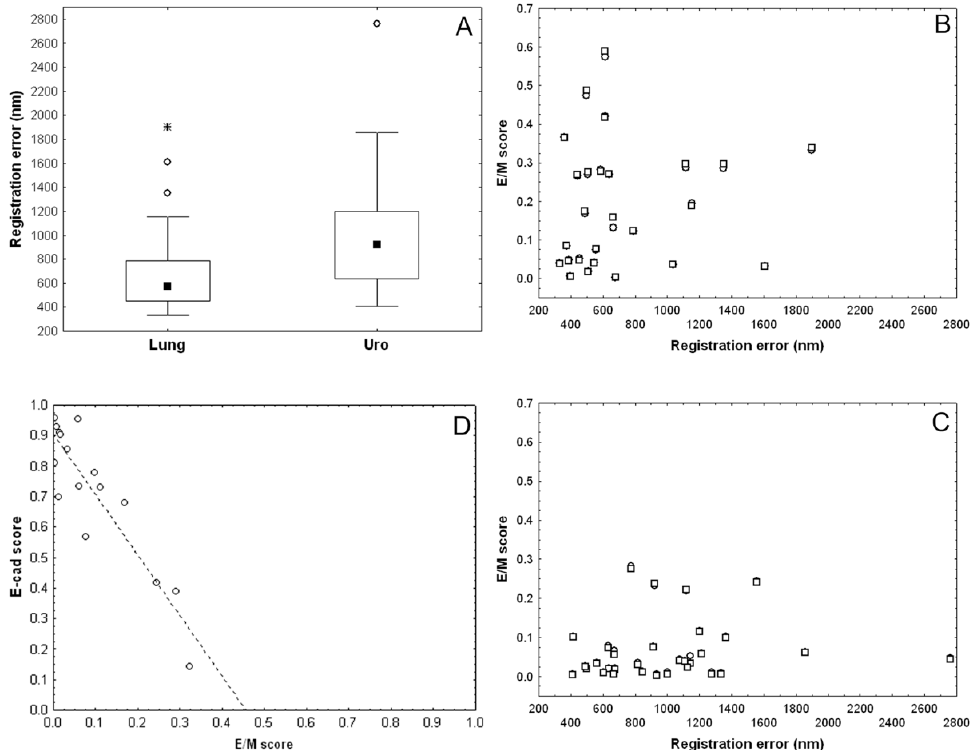
Figure 5. Validation of image registration and hybrid E/M score evaluation. ( a ) Registration errors (nm) on pairs of VIM and pan-CK virtual slides. E/M scores computed on lung ( b ), and urothelial ( c ) carcinoma samples at 10× (dots) and 5× (overlapping squares) magnification levels related to the registration error. Dots are not visible in cases of perfect match between the two scores. ( d ) Negative correlation between E-cad score and E/M score in urothelial carcinomas (Pearson r = − 0.90, n = 16).